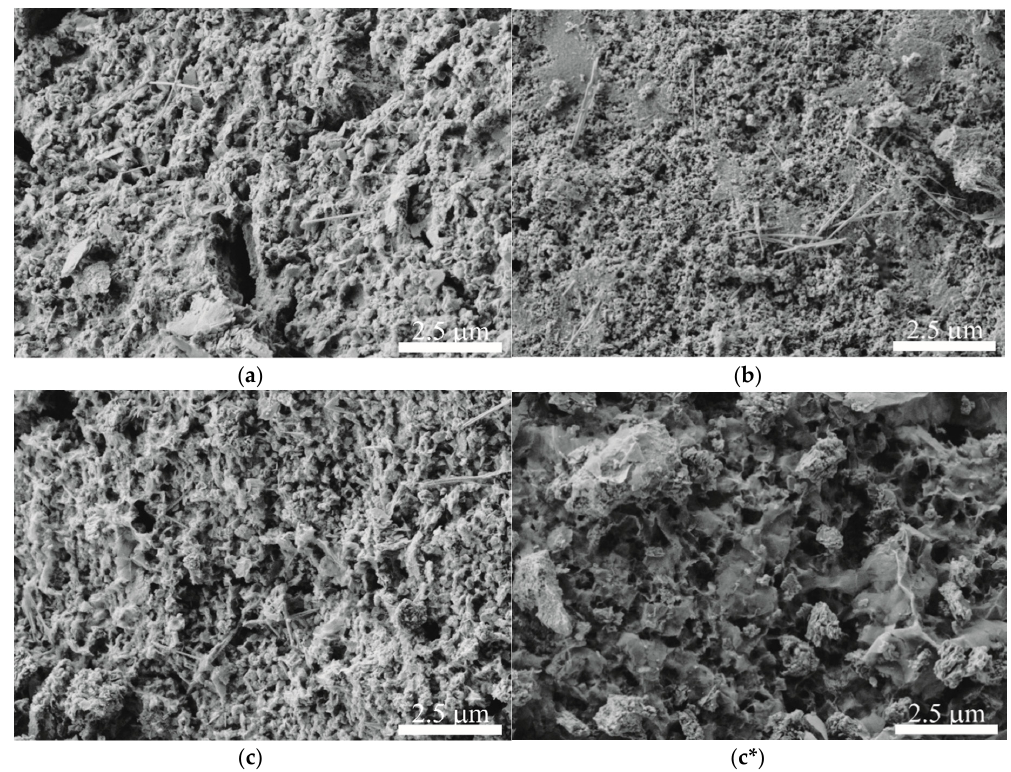
Figure 2. SEM images of the original birnessite ( a ), its regenerated form after three sorption cycles ( b ), and hydrazine-treated birnessite ( c , c* ).